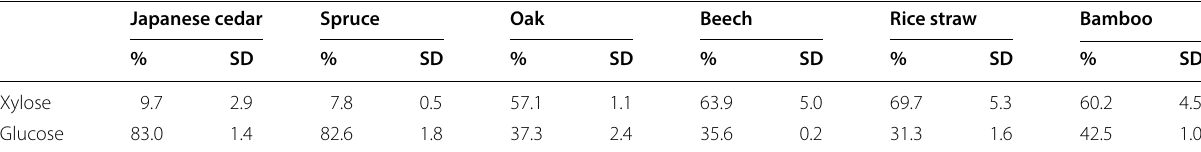
SD standard deviation; n